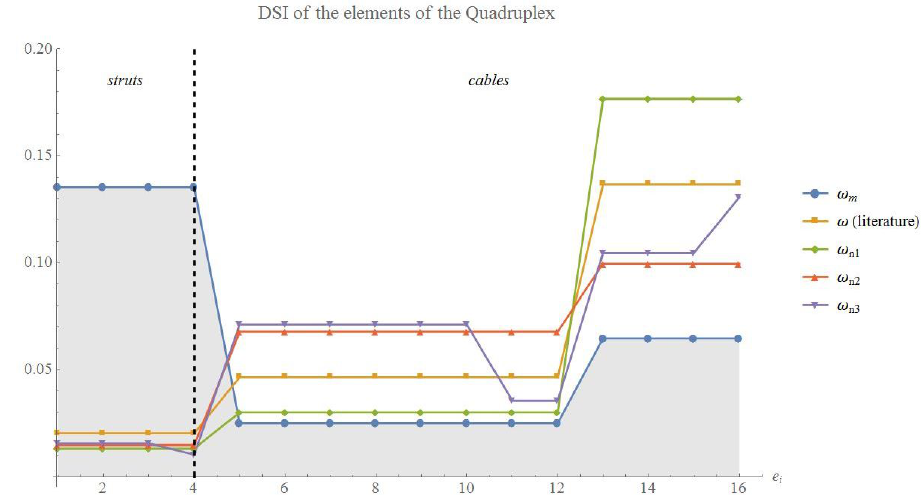
Figure 2: DSI of the elements of the Quadruplex for different assignments of the axial stiffness